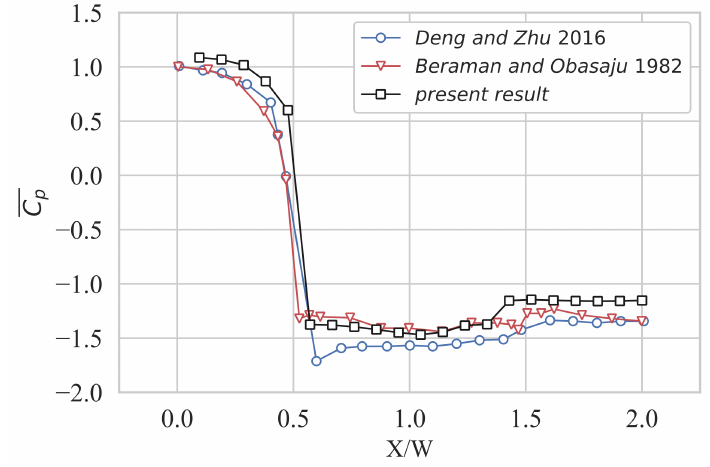
Figure 3. Comparisons of mean pressure distribution between previous studies and present numerical simulations. Table 2. Comparisons of force coefficients between previous studies and present numerical